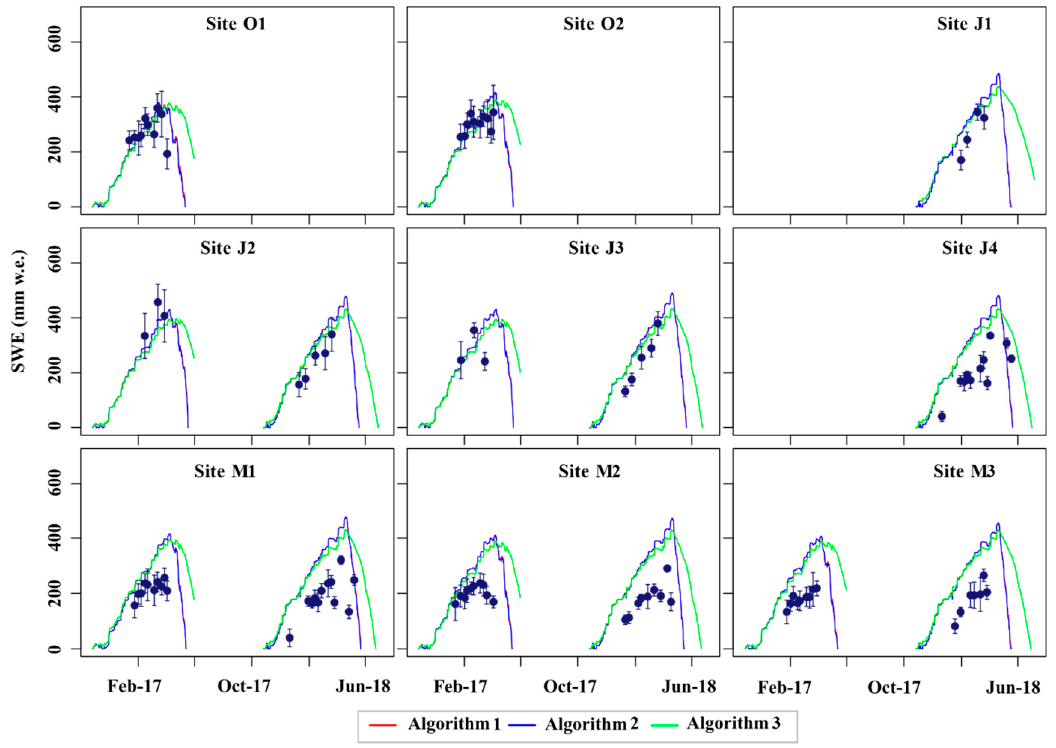
Figure 3. Hourly observed and simulated snow water equivalent (SWE) for the three temperature-index (TI) algorithms. Points illustrate the average SWE and the error bars denote the standard deviation. Note that the curves of algorithms A1 and A2 are almost completely superimposed.